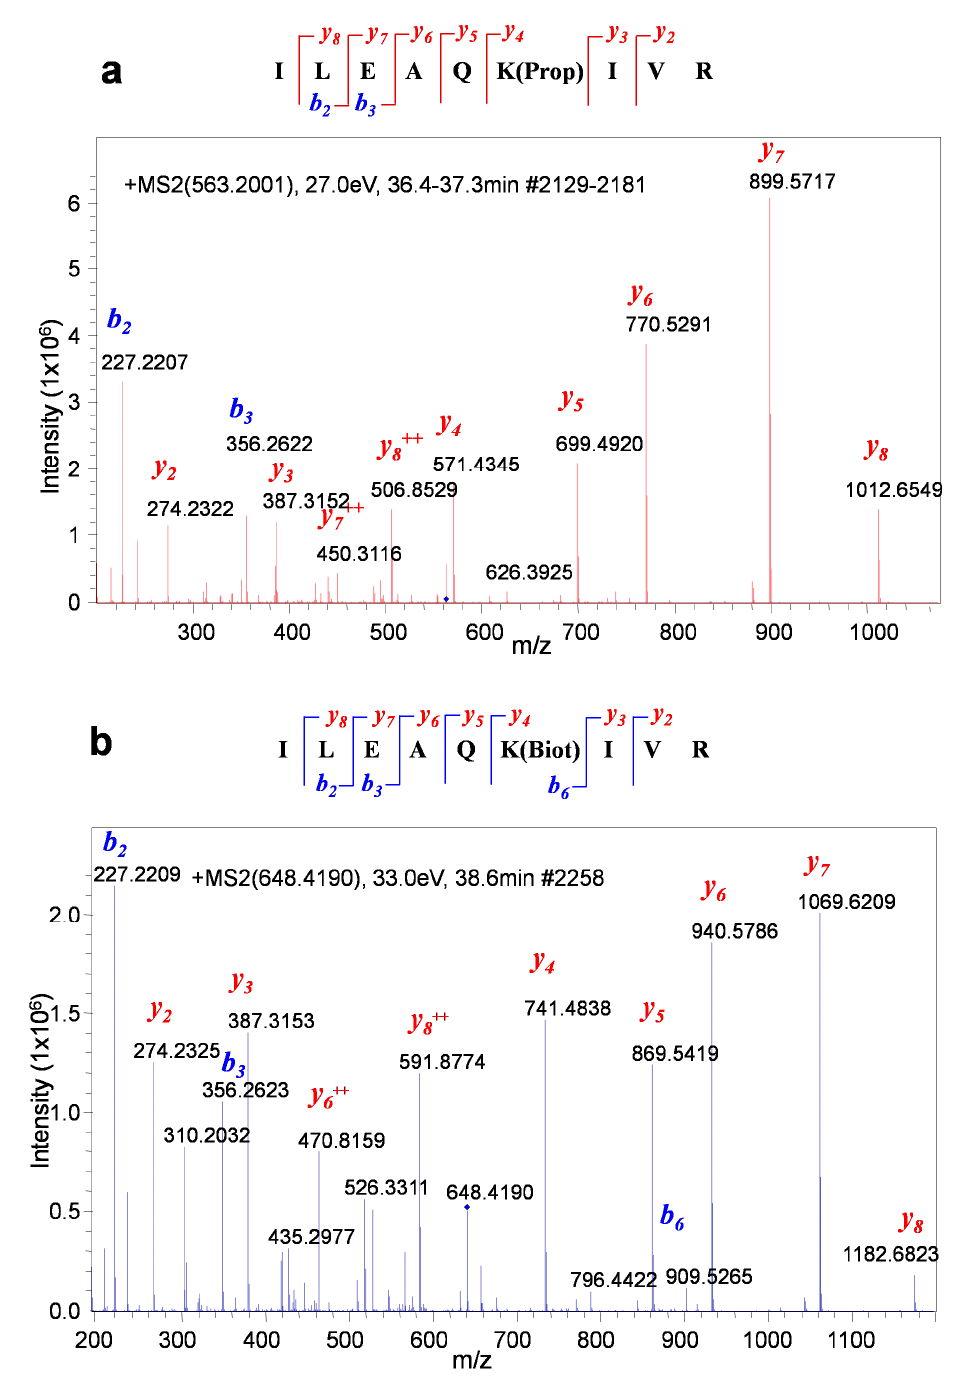
Figure 5. Propionylated and biotinylated BAP peptides (ILEAQK(propionyl)IVR and ILEAQK(biotinyl)IVR) can be unambiguously differentiated by MS/MS. ( a ) MS/MS spectrum of a propionylated BAP peptide. ( b ) MS/MS spectrum of a biotinylated BAP peptide.